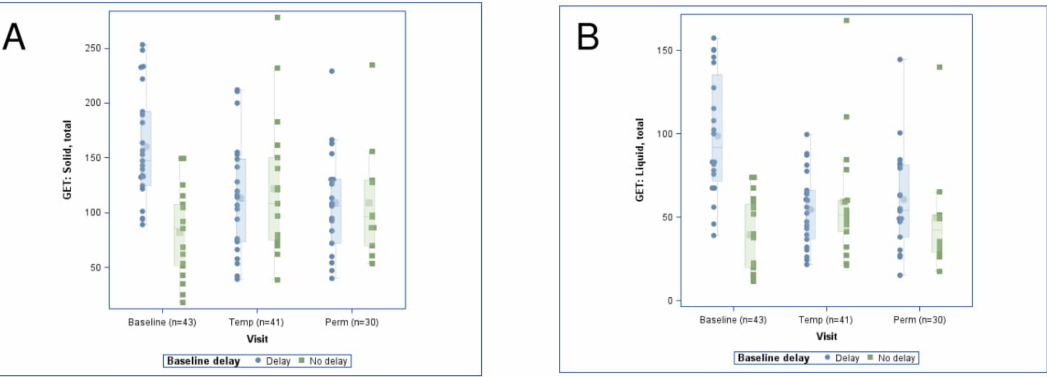
Figure 2. Pro-kinetic e ff ect with low and medium energy gastric electrical stimulation (GES). Stratified changes over the study period in solid ( A ) and liquid ( B ) gastric emptying according to delay status based on either 1-h liquid or 4-h solid retention